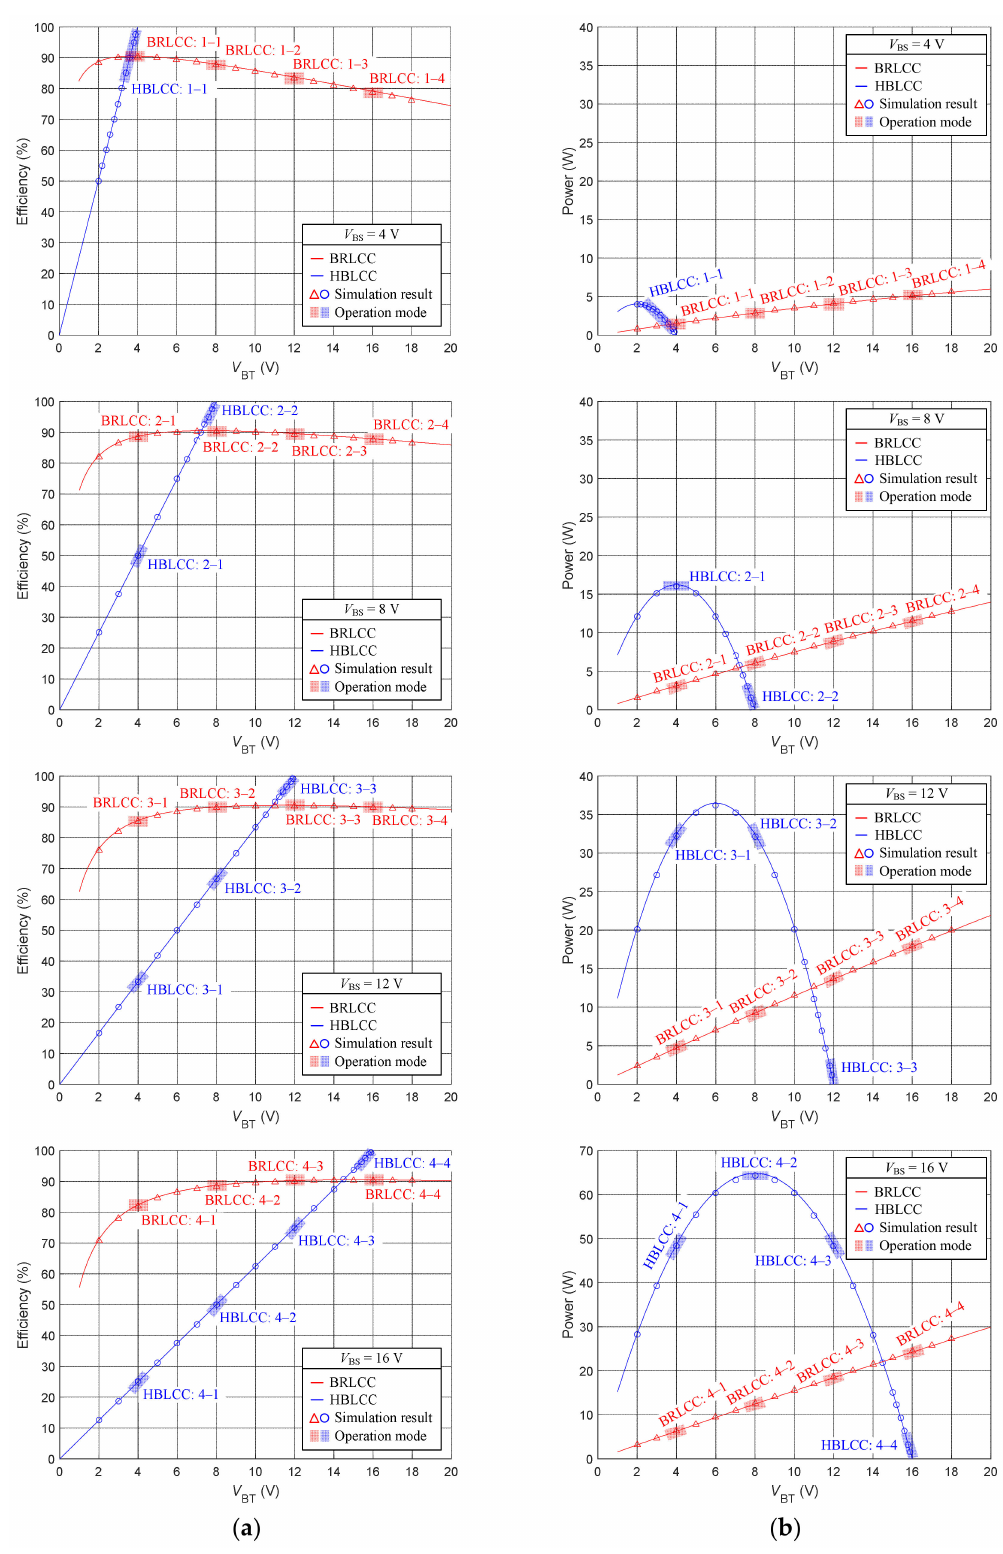
Figure 9. Balancing efficiency and power comparison of the proposed BRLCC equalizer with HBLCC equalizer in different operation modes. ( a ) Balancing efficiency. ( b ) Balancing